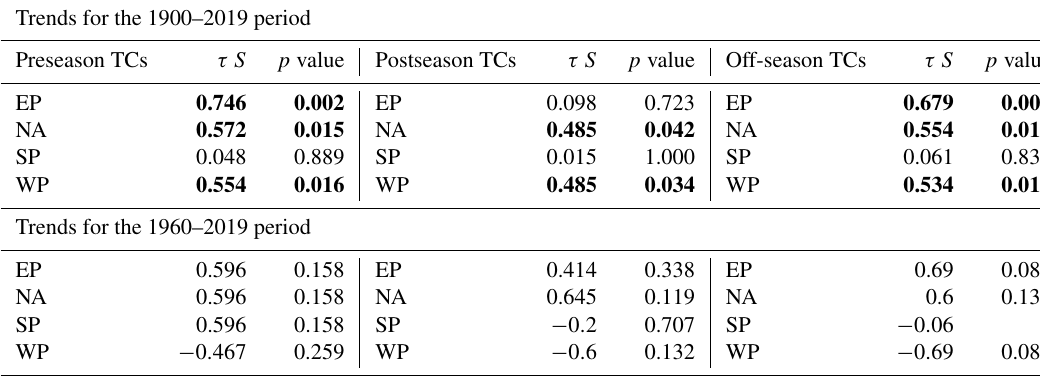
Table 2. Results of Mann–Kendall trend tests for the 1900–2019 period for all ocean basins where TCs form. Trends for the 1900–2019 period